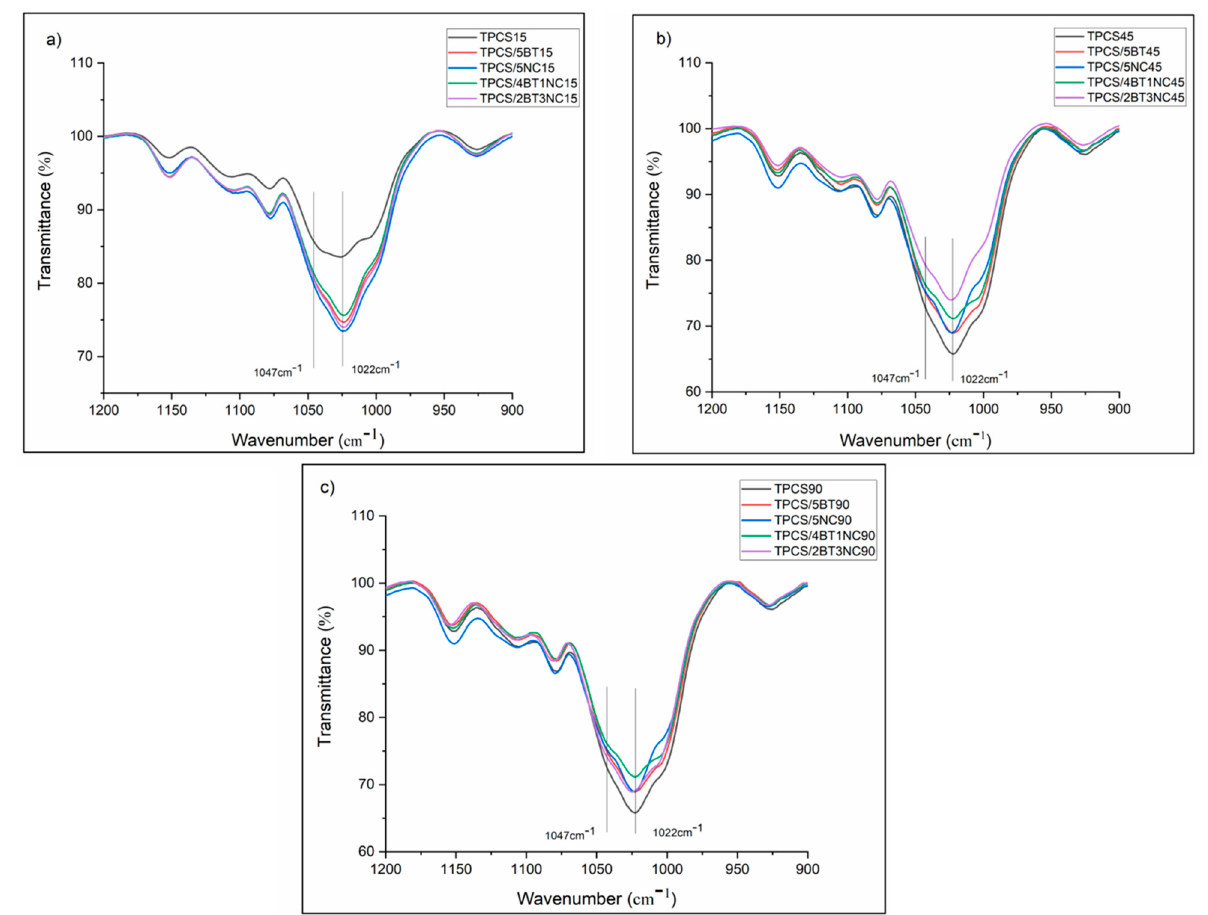
Figure 5. FTIR spectrum scan for neat TPCS, TPCS-C, and TPCS-HC films aged for ( a ) 15, ( b ) 45, and ( c ) 90 days from the range 900-1200 cm − 1 . Table 4. The ratio of 1047 cm − 1 :1022 cm − 1 (C value) of TPCS, TPCS-C, and TPCS-HC films after 15, 45, and 90 days of aging.